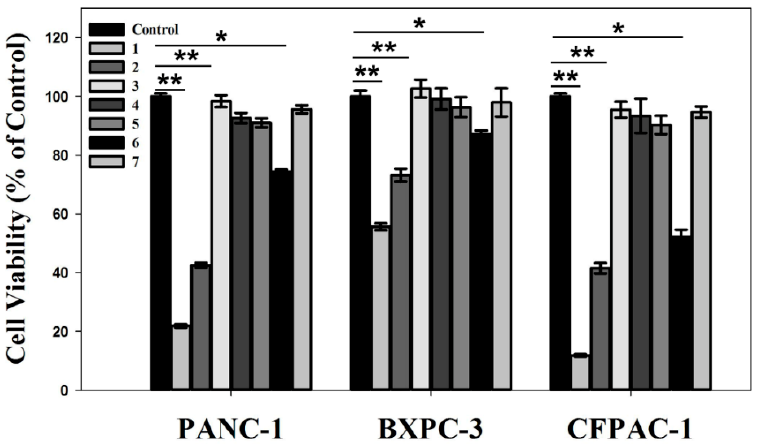
Figure 9. In vitro anti-pancreatic cancer effect. PANC-1, BXPC-3, and CFPAC-1 cell viability after treatment by (1) siRNA-Mate/siKras, (2) HAp-PEI/siKras, (3) DEPC H 2 O, (4) siKras, (5) HAp-PEI, (6) HAp/siKras, and (7) HAp-PEI/siNC for 72 h. Untreated cells were used as control. Values are represented as mean ± SD (n = 3). Statistical significance relative to the group of control: * p < 0.05, ** p < 0.01.